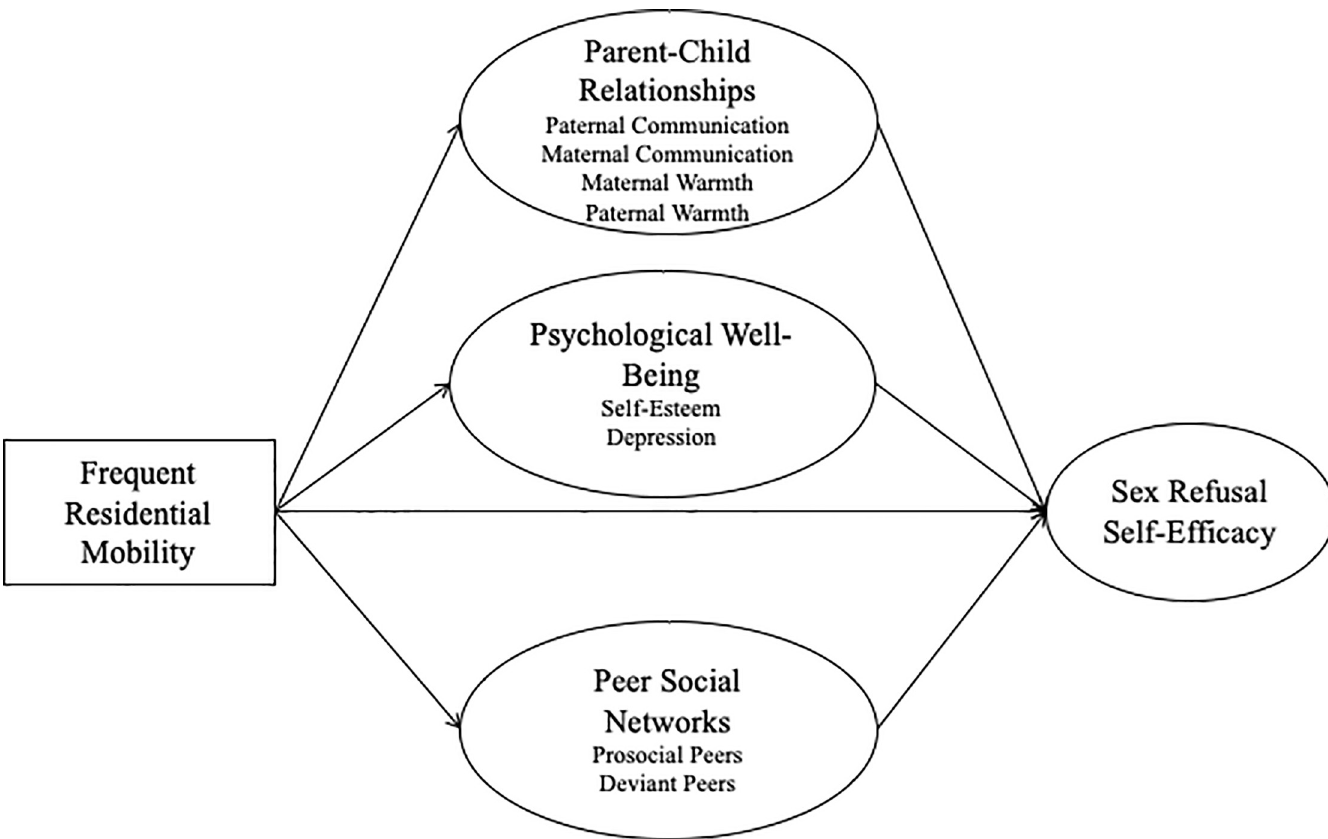
Fig 1. Proposed exploratory model of the direct effect of residential mobility on sex refusal self-efficacy and the plausible mediators. Direct effect between residential mobility and sex refusal-self efficacy and potential mediators of qualities of parent-child communication, psychological well-being, and peer social networks.